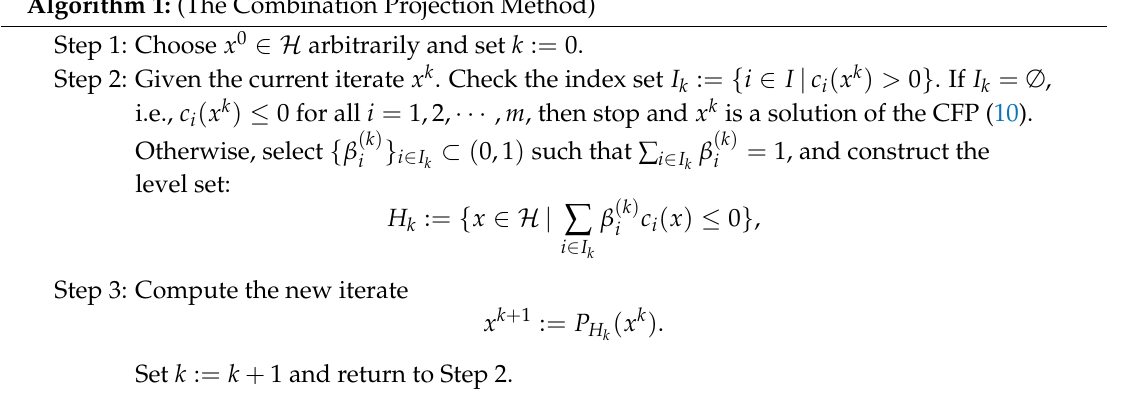
Algorithm 1: (The Combination Projection